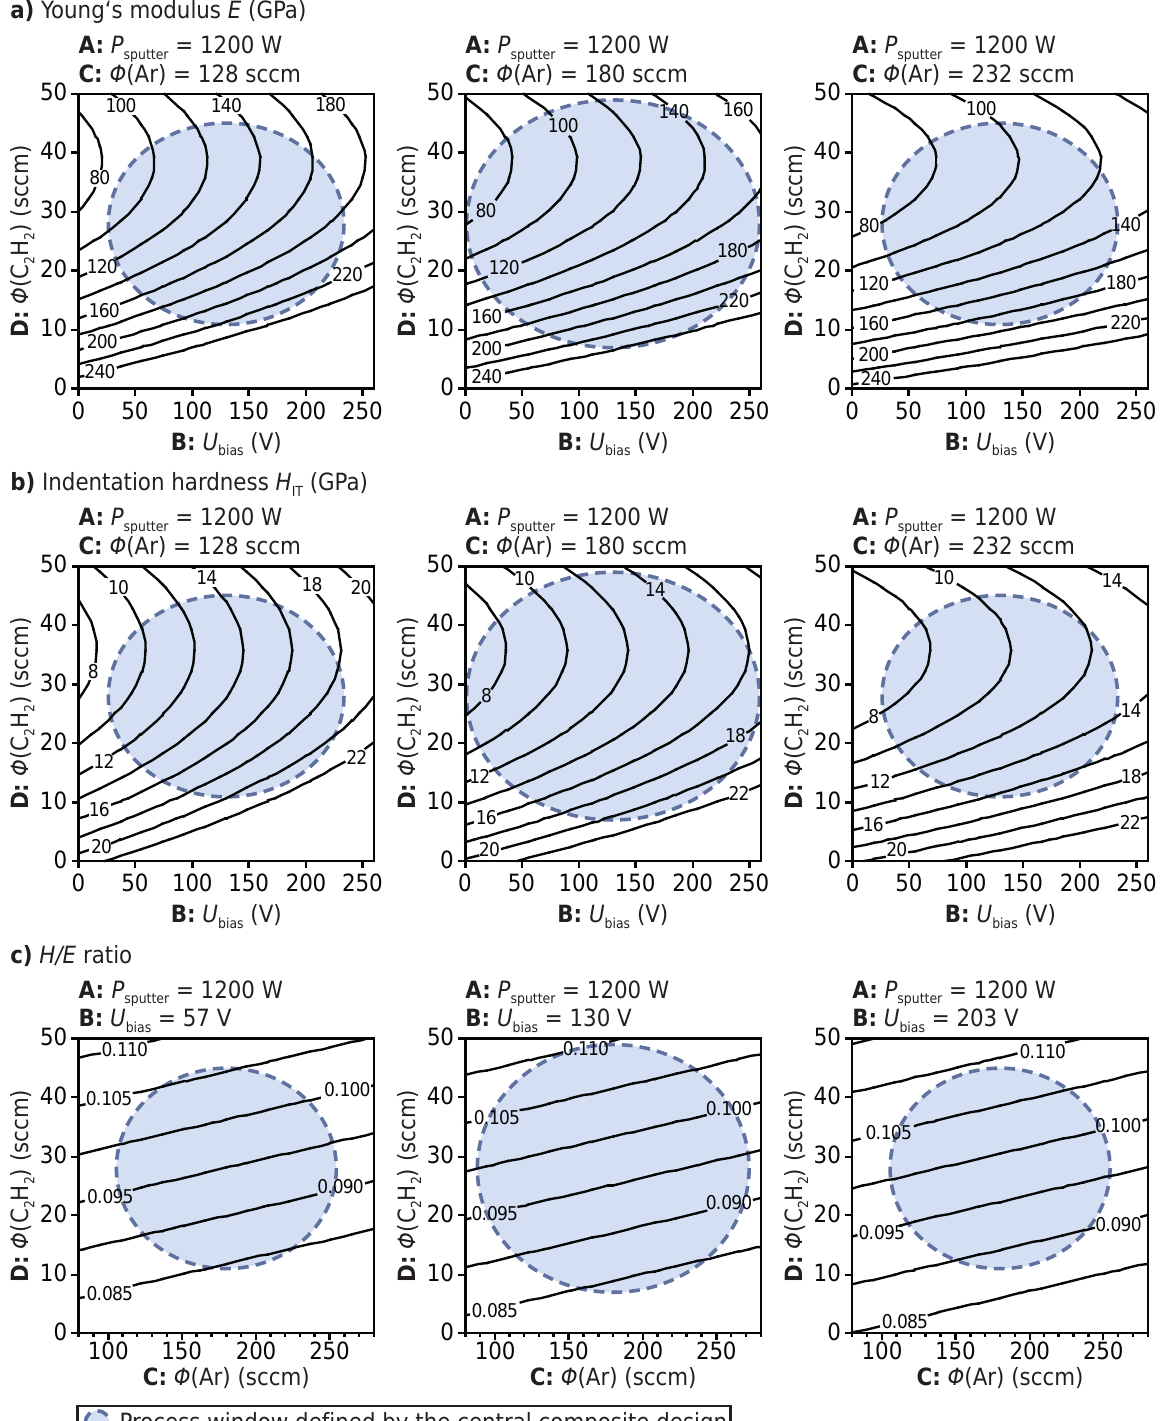
Figure 9. Contour line plots showing the statistical relationship between the three most influential deposition parameters, ethine flow rate, bias voltage and argon flow rate, at constant sputtering power and E ( a ), H ( b ), as well as H/E ( c ) of the a-C:H:W IT